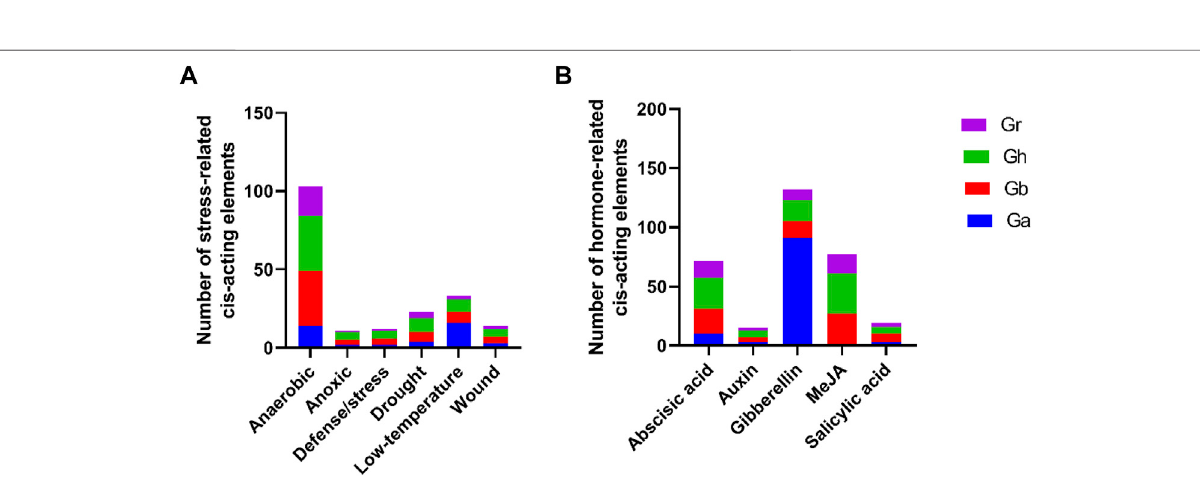
Frontiers in Genetics |